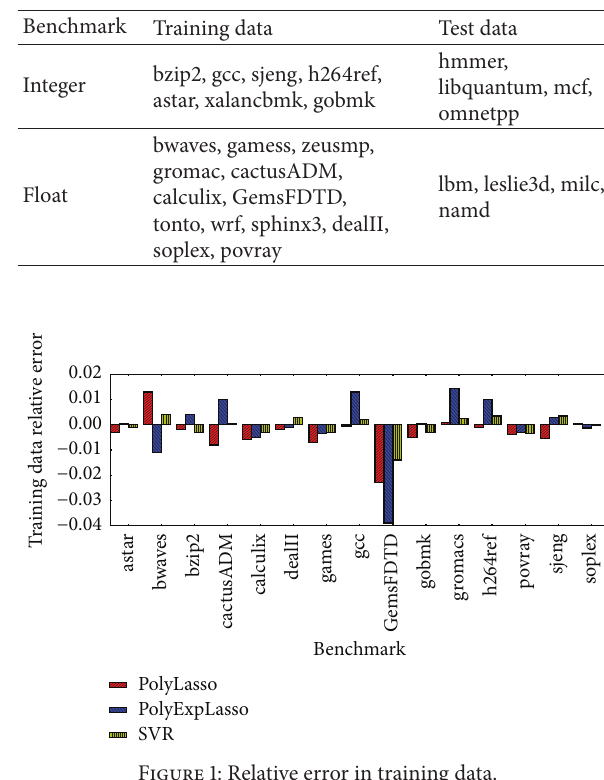
Table 1: Experimental data.